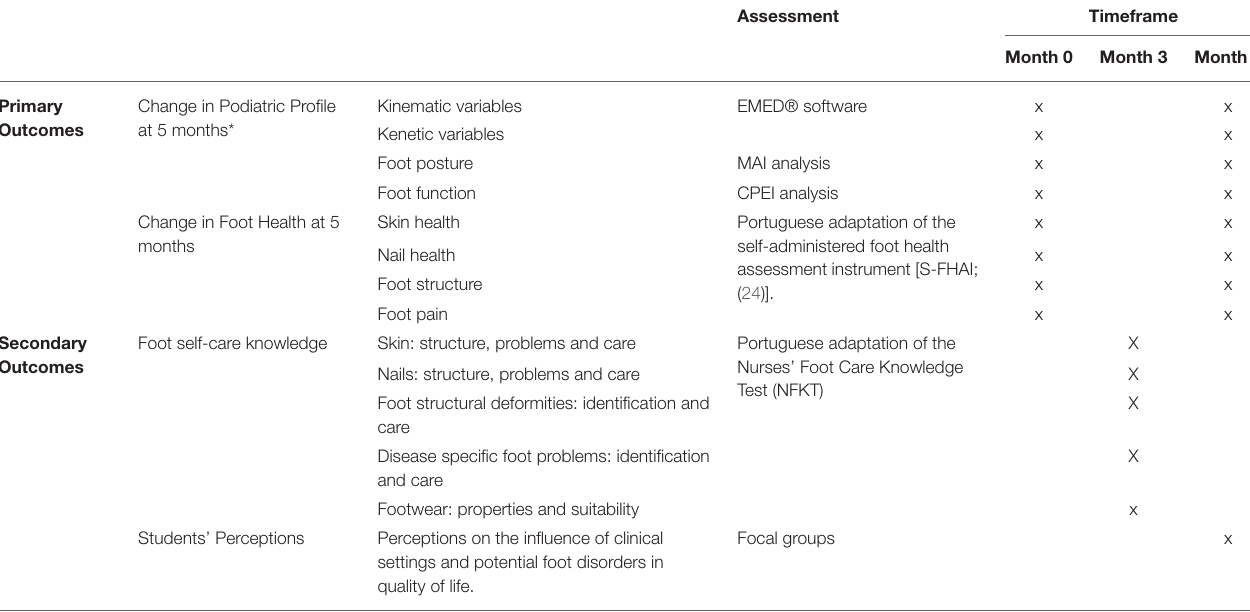
TABLE 2 | Primary and secondary outcomes